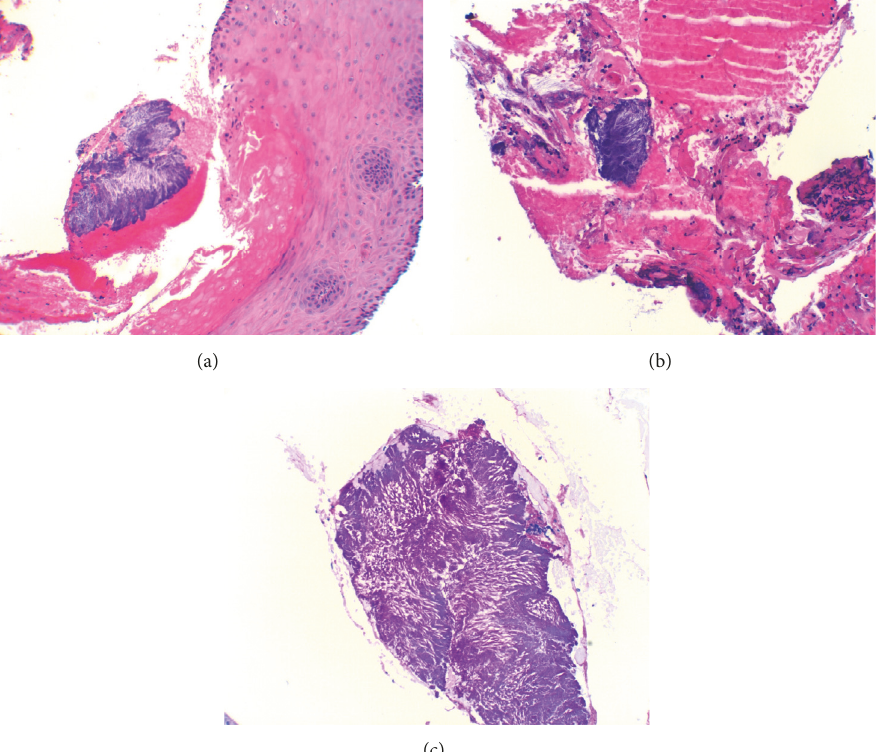
Figure 2: (a) Hematoxylin and eosin (H&E) stain showing esophageal squamous epithelium with hyperparakeratosis and hemorrhage secondary to Actinomyces presenting as sulfur granules (center blue). (b) H&E stain showing sulfur granules associated with esophageal epithelium degeneration, hemorrhage, neutrophils, and lymphocytes. (c) Periodic acid–Schiff stain showing organisms of Actinomyces presenting as sulfur granules and